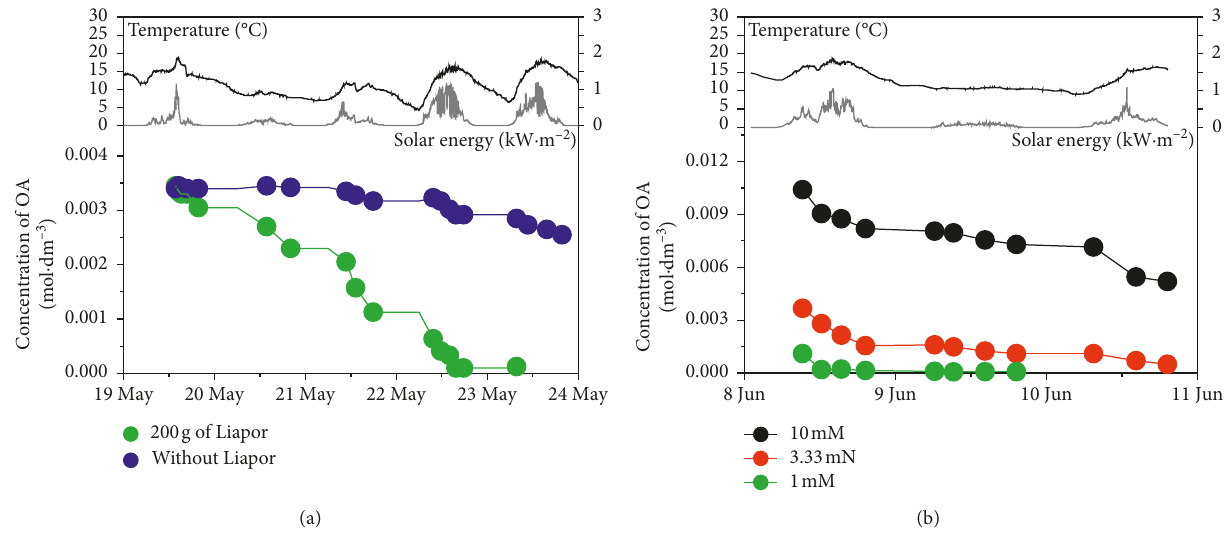
Figure 10: Photocatalytic degradation of OA. (a) Without (photolysis) and with coated, calcined Liapor. (b) Influence of OA concentration with coated, calcined Liapor, grain size 4–8mm.